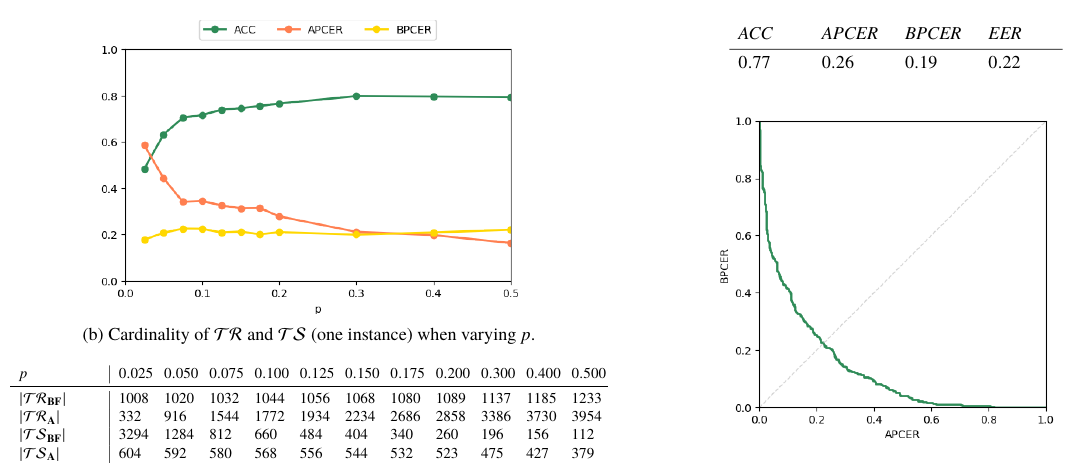
Figure 7. Results for the FERET -only